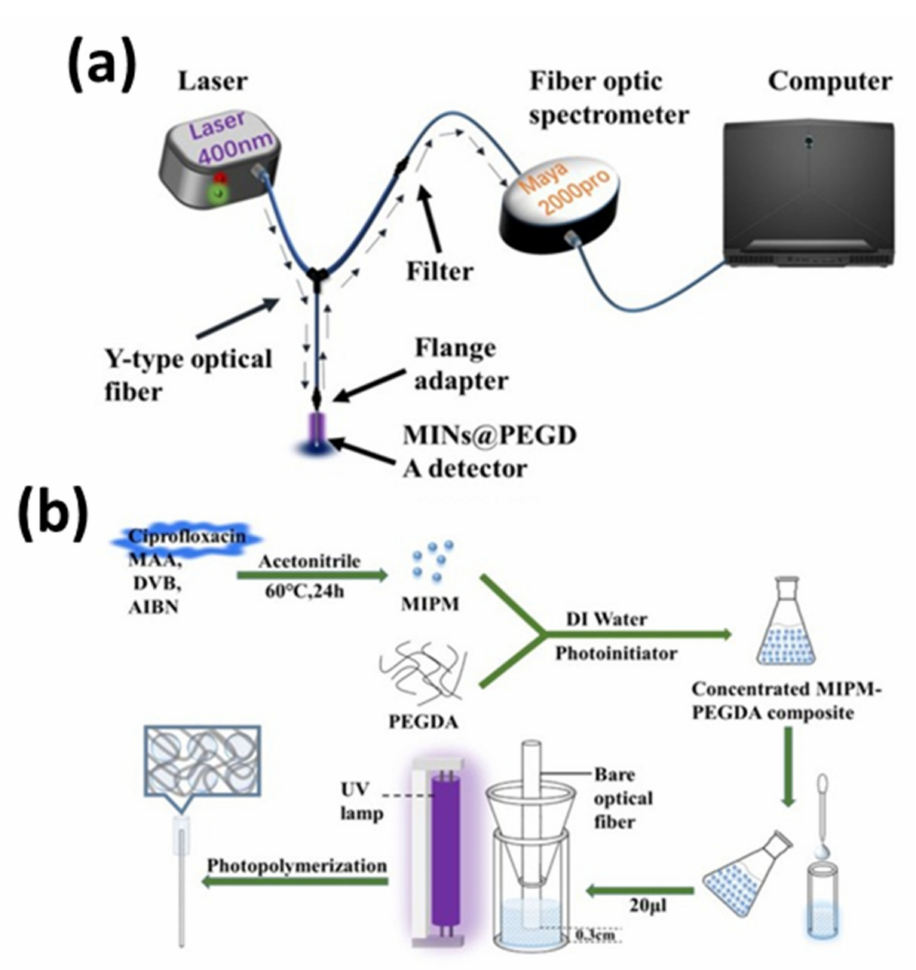
Figure 11. ( a ) Schematic of set up of molecularly imprinted fluorescence based optical fiber sensor, and ( b ) fabrication of molecularly imprinted nanoparticles and PEGDA composite (MINs@PEGDA) probe. Reprinted with permission from Ref. [83]. Copyright 2021